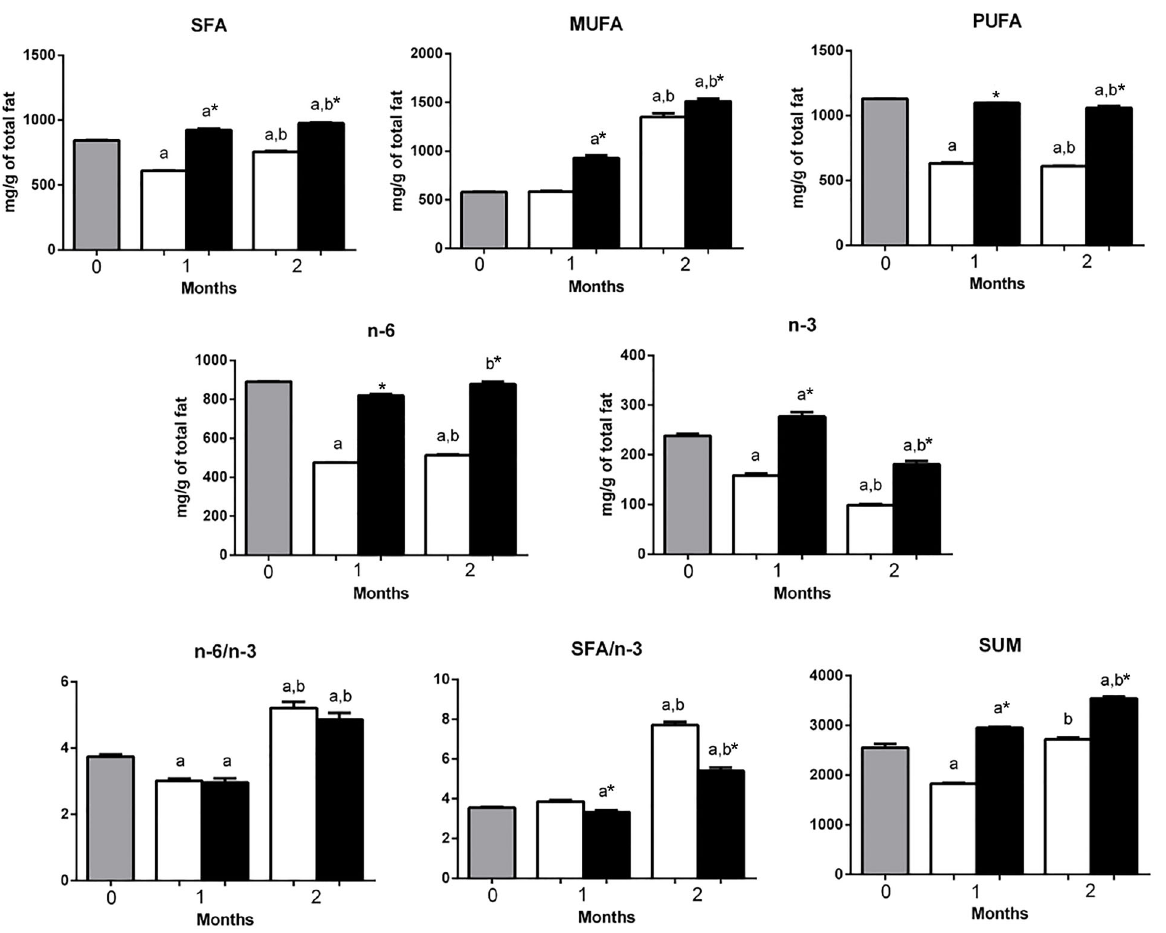
Figure 6. Fatty acid family composition and the n-6/n-3 and SFA/n-3 ratios in the gastrocnemius muscle of mice at 0 (before starting the diets, gray bars) or fed with a high-carbohydrate diet (HCD, white bars) or high-fat diet (HFD, black bars) for 1 or 2 months. Results are reported as means ± SE. *P o 0.05 compared to HCD group (Student ’ s t -test). a P o 0.05 compared to time 0; b P o 0.05 compared to 1 month (one-way ANOVA). SFA: total saturated fatty acids; MUFA: total monounsaturated fatty acids; PUFA: total polyunsaturated fatty acids; SUM: sum of all fatty acids evaluated.